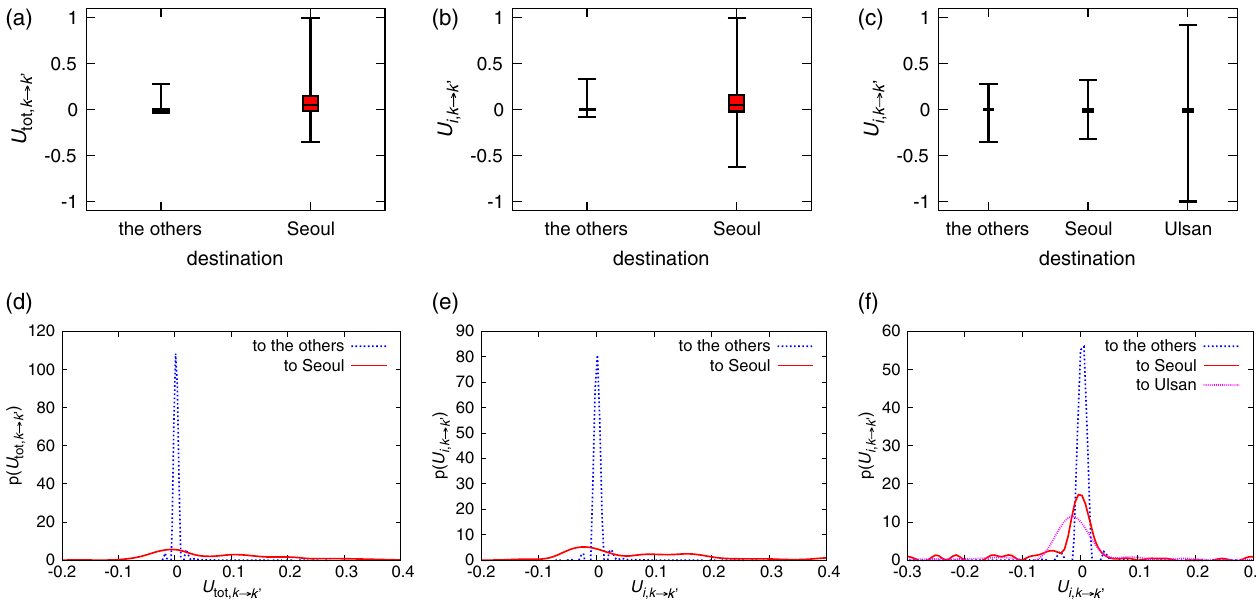
FIG. 14. We show box plots for the distributions of (a) U for Lee from Hakseong, where the boxes indicate quartile values and the whiskers give the minimum and maximum values. We also show the probability distributions for (d) U Hakseong. In all cases, we apply CSPLINE smoothing in GNUPLOT to the histograms using 50 equally-sized